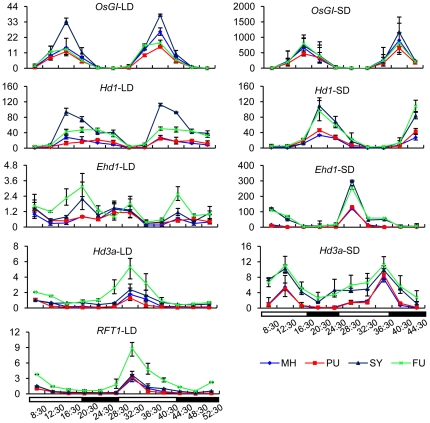
Effects of OsHDT1 on flowering time gene expression.Diurnal expression of OsGI, Hd1, Ehd1, Hd3a and RFT1 in MH63, OsHDT1 over-expression in MH63 (PU), SY63 and OsHDT1 over-expression in SY63 (FU) under long day (left) and short day (right) conditions, revealed by qRT-PCR. Values relative to the transcript levels in MH63 at 8:30 (arbitrarily set as 1) are presented. Error bars, s.e.m. from 3 biological repeats.